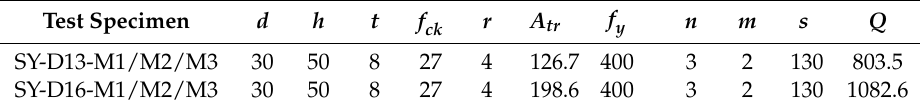
Table 6. Shear resistance evaluated with Equation (1)